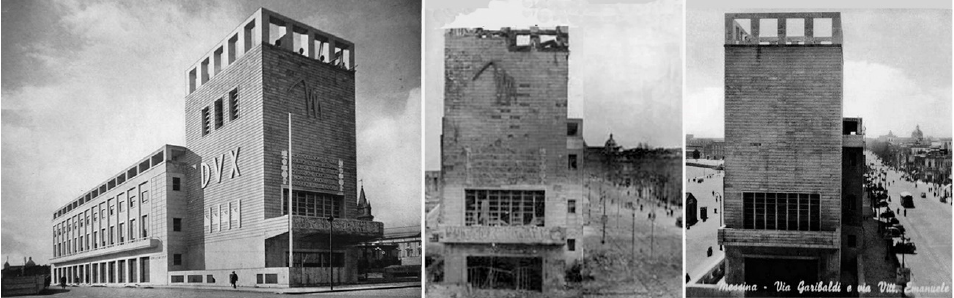
Figure 9. The Fascist House (block VII): from inauguration to post-war restoration of fi rmitas